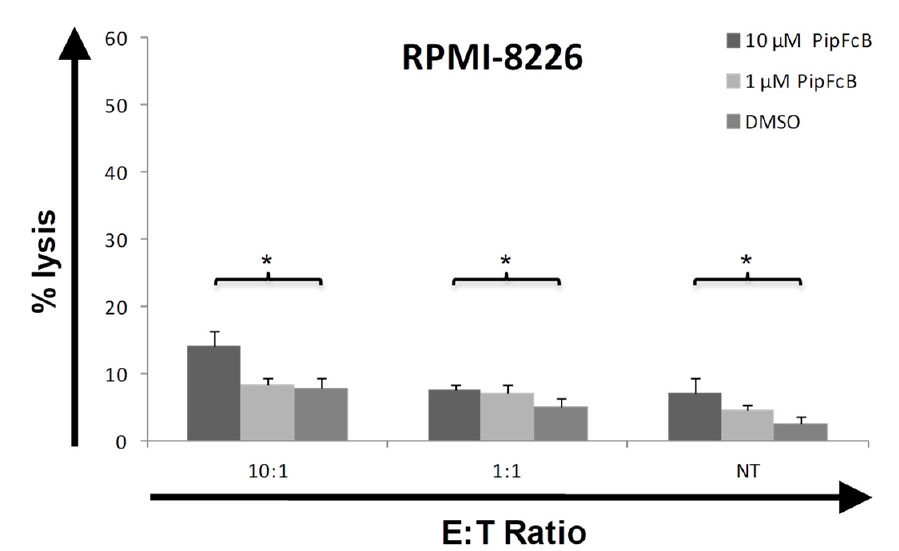
Figure 5. Influence of PipFcB on the cytotoxic capacity of CARTs against CD19 − cells. Cytotoxicity of CD19-specific CARTs was determined by 51 Cr release assay after co-culture with the CD19 − multiple myeloma cell line RPMI-8226. Co-incubation with CARTs in different E:T ratios (10:1, 1:1) and non- transduced T cells (NT) was performed for 4 h. Different concentrations of the specific ROS accelerator PipFcB (10 µM, 1 µM) or DMSO (vehicle) were added simultaneously with CARTs to the culture. PipFcB significantly increased unspecific lysis by CD19-specific CARTs and NTs in CD19 - multiple myeloma cells. All experiments were performed in triplicates. Mean values were calculated for each group; error bars indicate standard deviation (* p < 0.05).